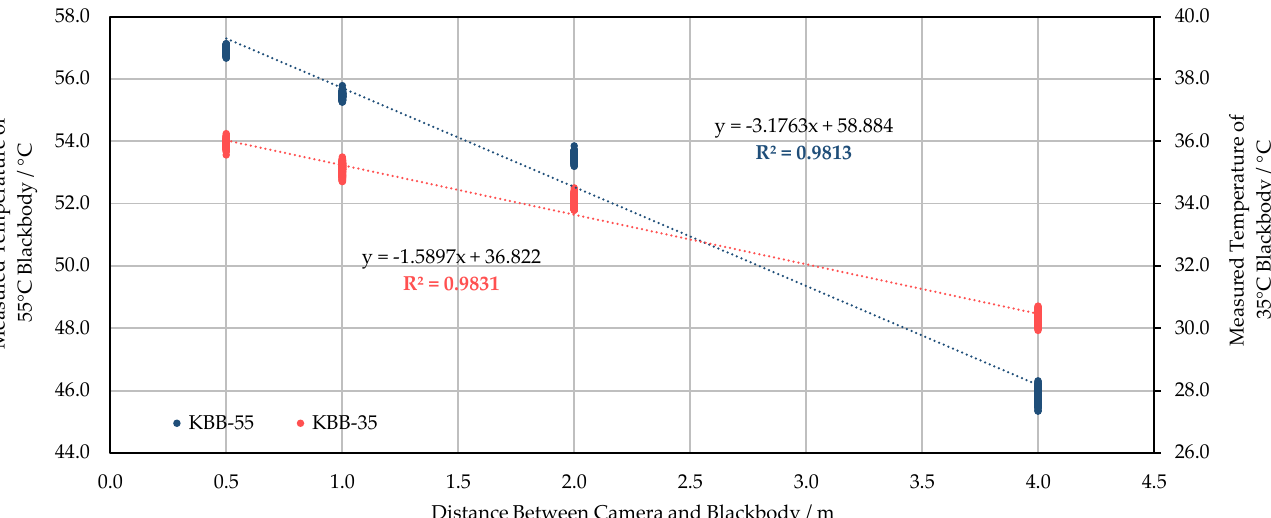
Figure 9. The correlation between the measured temperature by WIRIS and the measuring distance. These sessions were conducted at the blackbody temperature of 55 °C ( a ) and 35 °C ( b ). The STD of temperature observation is also included in the charts above.